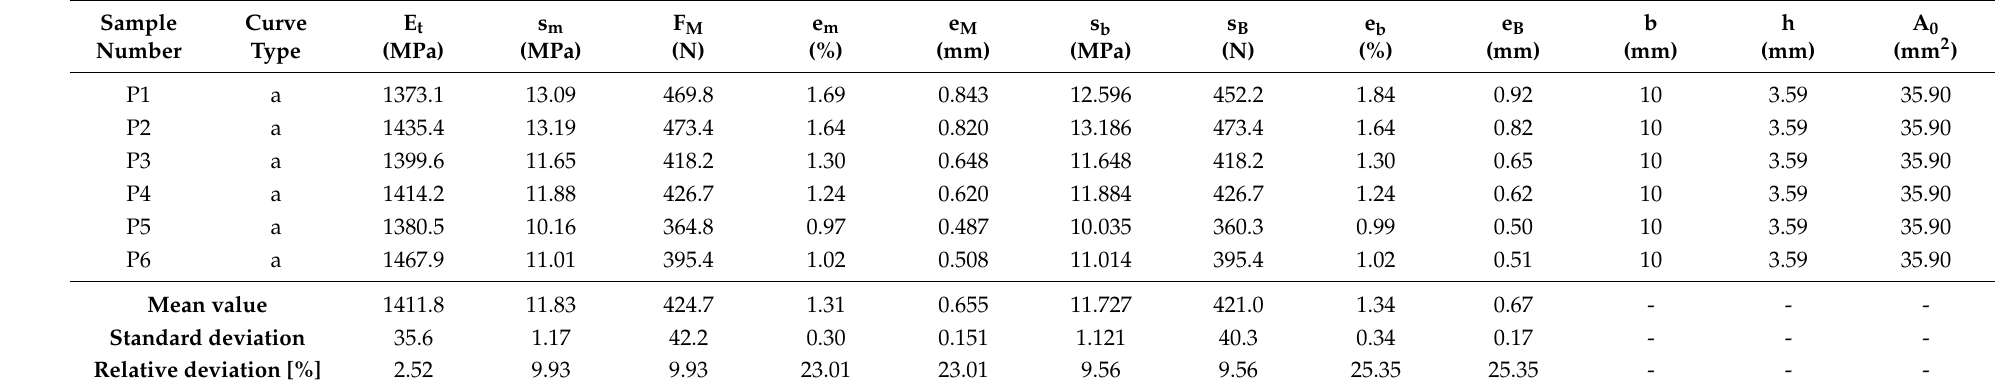
Table A30. Results of the tensile tests of P_PP.